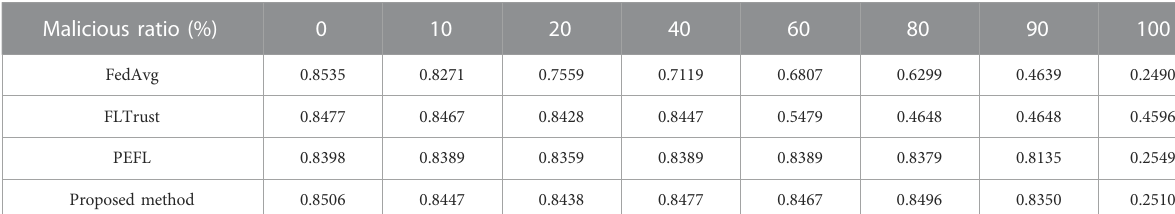
TABLE 4 The effect of malicious client ratio on accuracy. Malicious ratio (%)